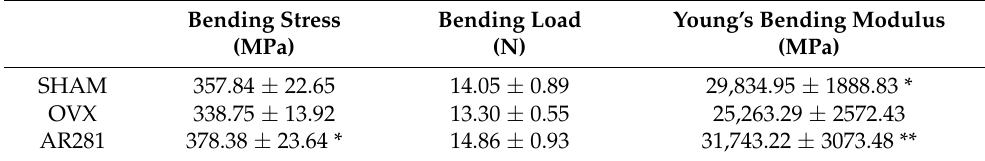
Table 1. Effects of L. brevis AR281 on bone-breaking